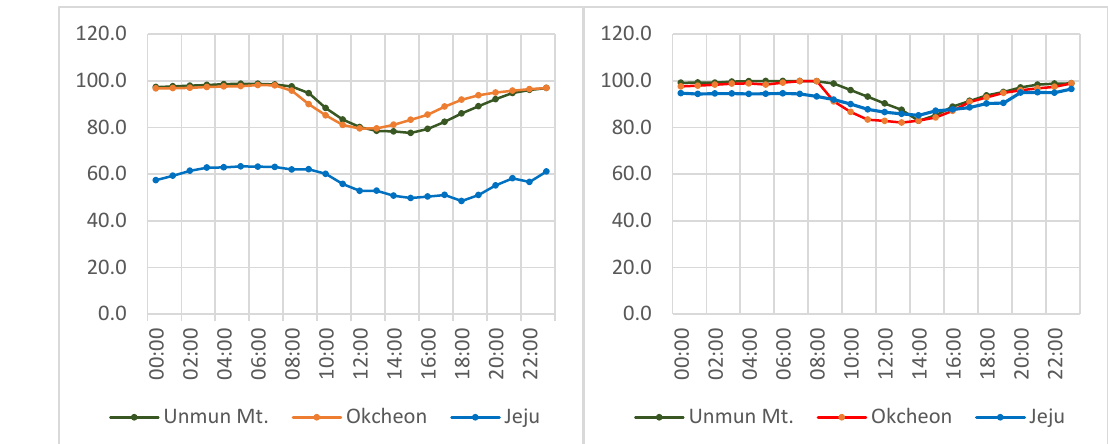
Figure 4. L. unmunsana habitats with continuously wet valleys (except for Jeju Island). Though there is no major river or lake on Jeju Island, the humidity derived from